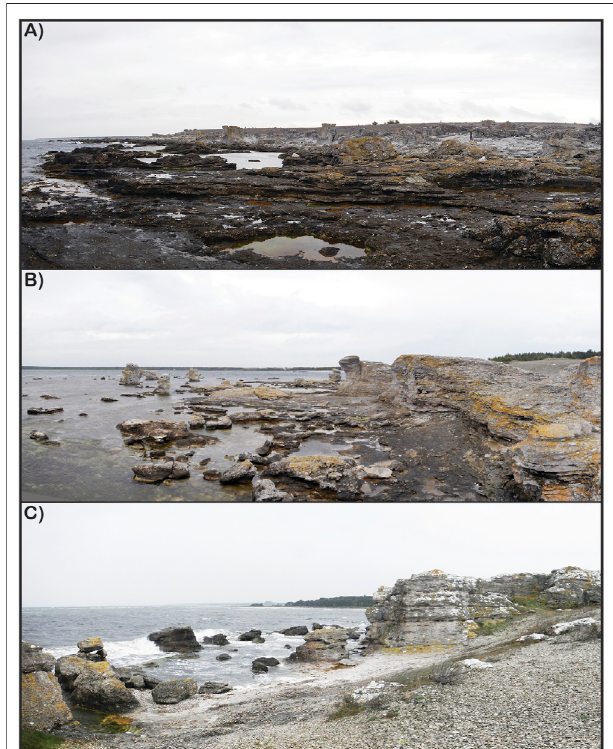
FIGURE7| Examplesofruinedraukcoastswithstacks(rauks)undercut by waves and collapse on the shore platforms: (A) largest collapsed rauk fi eld in Digerhuvud, Fårö; (B) disintegrated rauks and rock blocks chipped of limestone cliffs in Gamlehamn, Fårö; (C) “ stumps ” of collapsed rauks in Holmhällar,